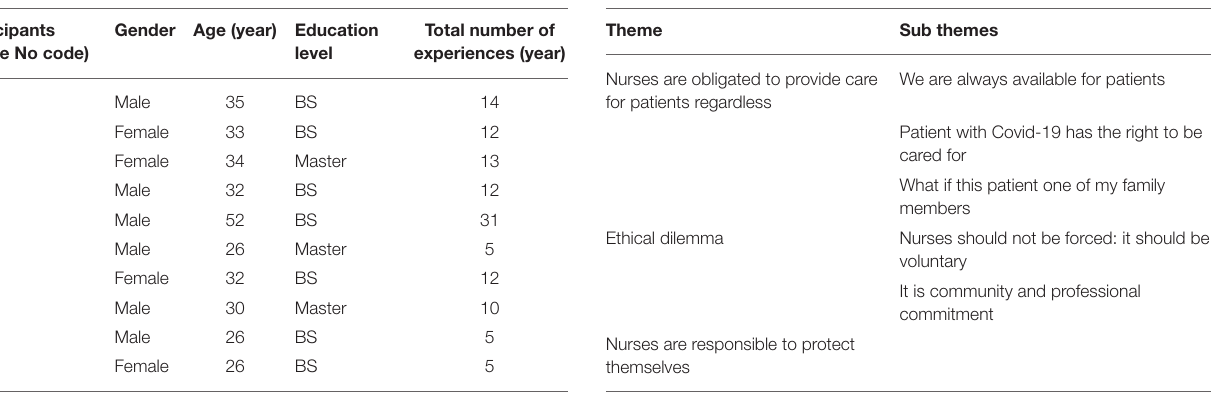
TABLE 1 | Participants demographics